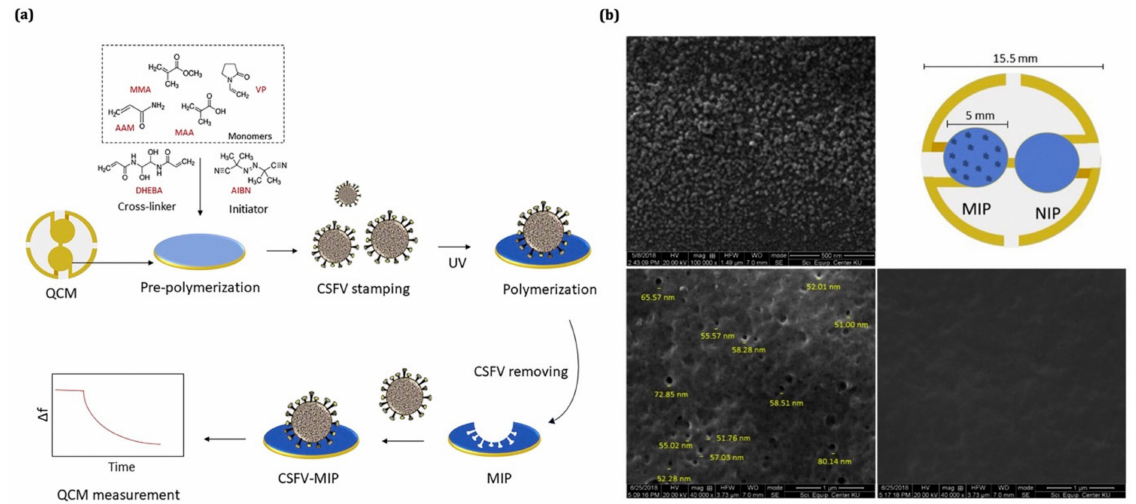
Figure 8. ( a ) Schematic image of design of MIP-QCM sensors; ( b ) SEM image of polymer surface Reprinted with permission from ref. [165]. Copyright 2020